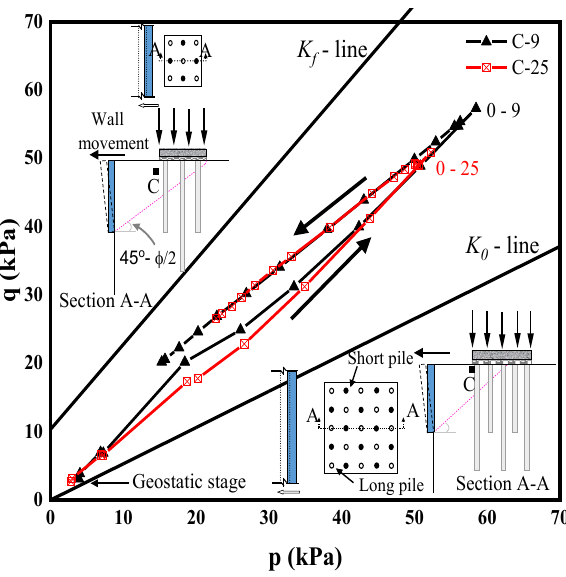
Figure 9: Stress paths experienced by a soil element C for groups with 9 and 25 long–short CFG piles situated at 3 m behind the wall (C-9 indicates element C in a group with nine